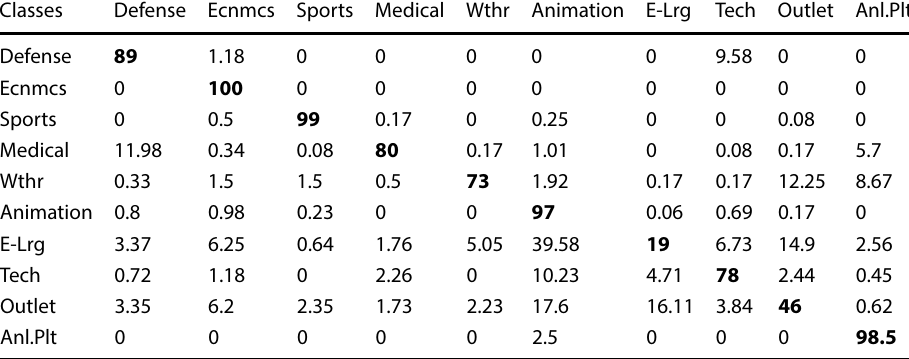
Table 4 Confusion matrix of the Roy et al. method [8] on STD dataset (ACR: 76.0%)